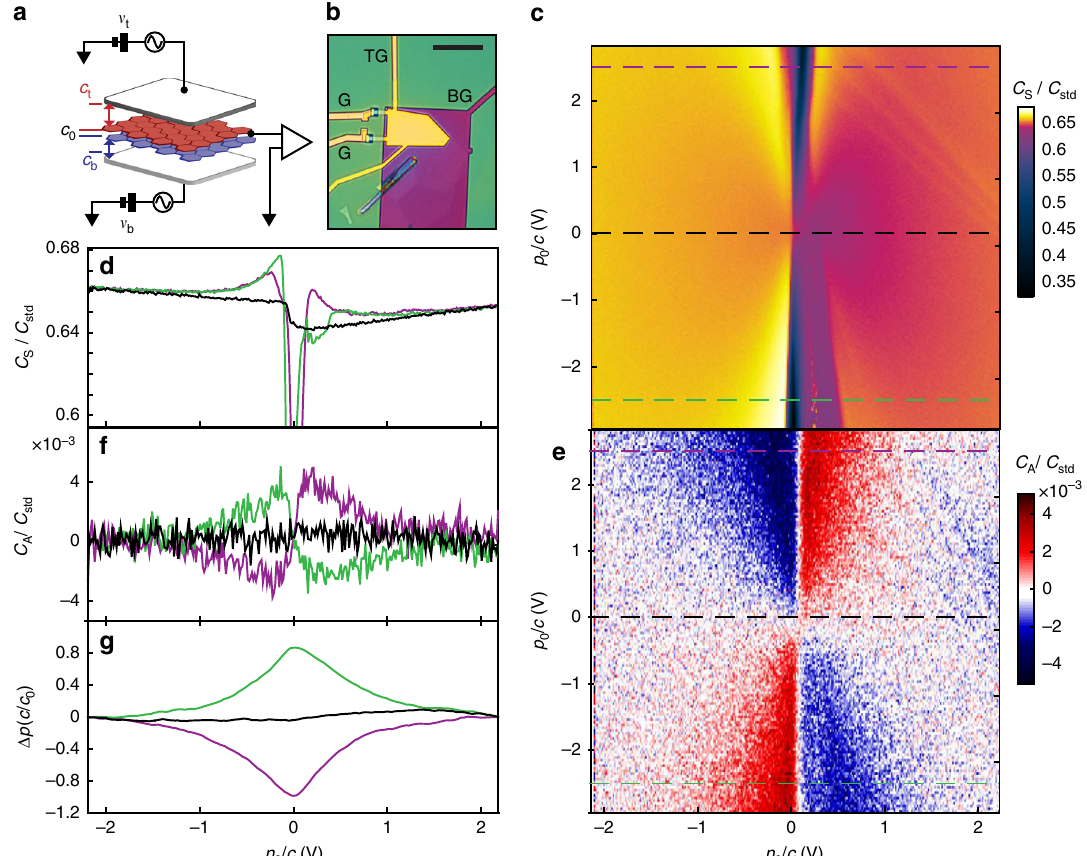
Fig. 1 Layer polarization of bilayer graphene at zero magnetic fi eld. a Measurement schematic showing geometric gate capacitances c t and c b and interlayer capacitance c 0 . Capacitance is measured using a cryogenic bridge circuit by comparison with a standard capacitor C std , measured to be 404 ± 20 fF (see “ Methods ” ). b Device image. Top gate (TG), back gate (BG), and contacts to bilayer graphene (G) are shown. Scale bar is 10 μ m; device area is approximately 87 μ m 2 . c C S measured at B = 0 and T = 1.6 K as a function of n 0 / c = v t + v b and p 0 / c = v t − v b . A p 0 -dependent band gap is visible as the dark region near n 0 = 0. d Line traces taken at different values of p 0 , corresponding to dashed lines in c . Band edge van Hove singularities 28 and electron-hole asymmetry 27 are both evident. e C A measured under the same conditions. A common, constant background has been subtracted to account for fi xed parasitic capacitances. f Line traces at different values of p 0 corresponding to dashed lines in e . g Integrated change in polarization, c 0 the constant of integration fi xed to be zero at high n 0 j j . In accordance with single-particle band structure 28 , wavefunctions are layer unpolarized for p 0 = 0, while for large p 0 j j the polarization peaks at n 0 = 0, where band wavefunctions are strongly layer